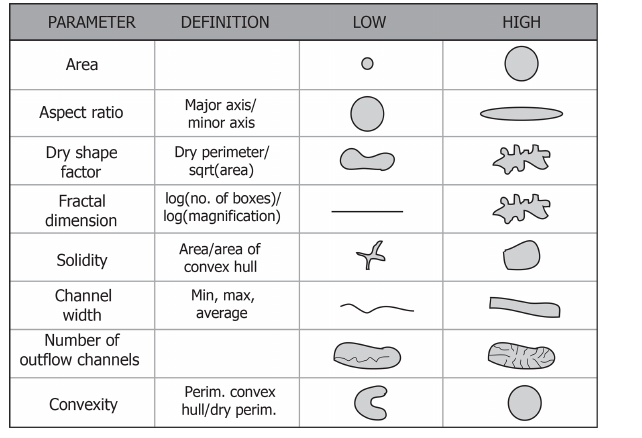
Figure 2. Illustration and definitions of parameters, or metrics, used in this analysis. For channel width, three values (the minimum, av- erage, and maximum values) are used, bringing the total number of parameters to